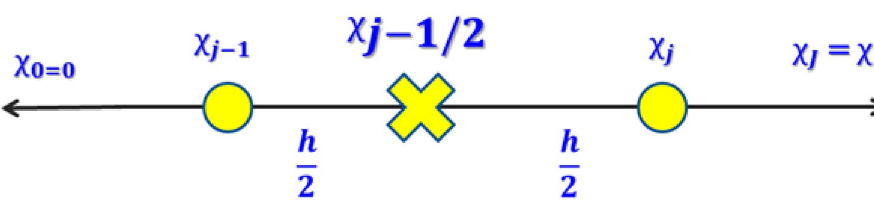
Figure 5. Rectangular grid of difference